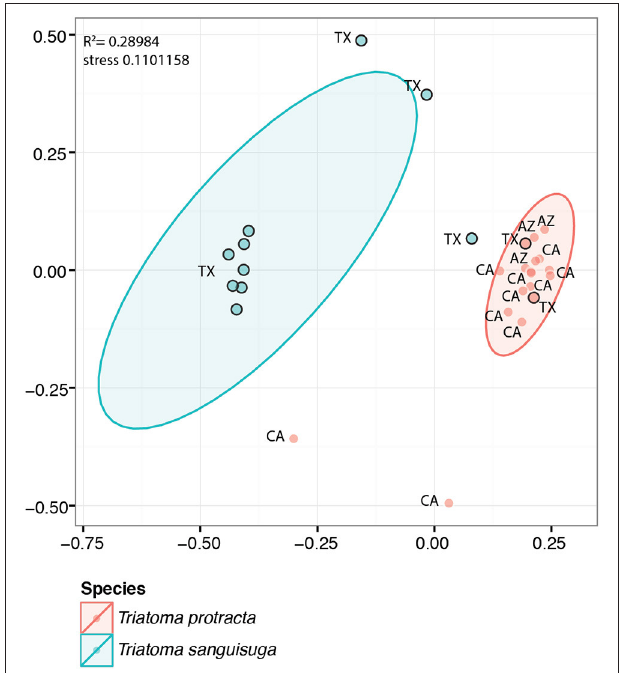
FIGURE 3 | NMDS visualization of significant differences between the microbiomes of T. protracta and T. sanguisuga sampled from wild populations. The abbreviations stand for the states where the bugs were sampled. The black border circles designate samples for which the bioinformatic abdomen was generated (see Material and Methods section). The ellipses are 95% confident ellipses calculated with the stat_ellipse function of ggplot2 package.